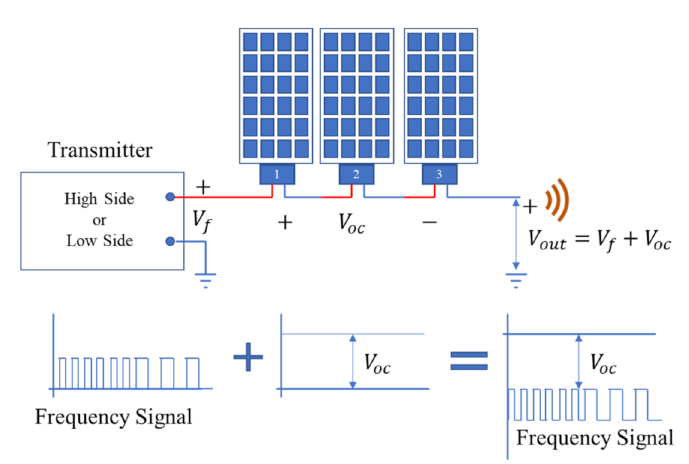
Figure 23. Receiver for disconnection detection.